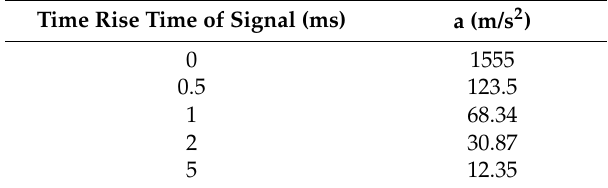
Table 2. Maximum linear accelerations of driving foot under different signals.